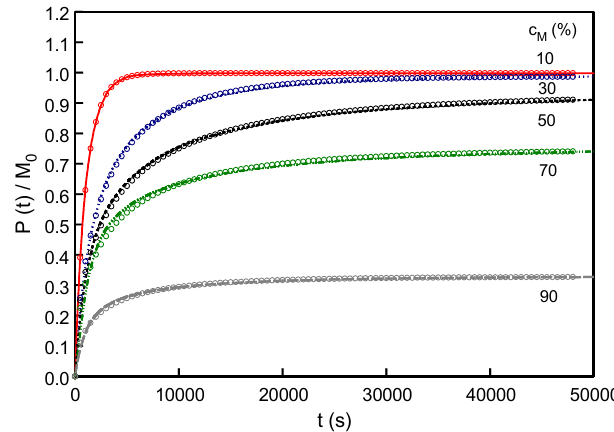
Figure 2. CA simulation data (solid lines) showing the dynamical dependence of photo-product creation for various c M . The symbols show the optimum fit of Equation (1) to the CA curves. In all cases L = 1 µ m, N = 1250, C = 50, c O = 1%, α 0 = α 1 = α 3 = 0, α 2 = 10 5 cm − 1 , β = 10 − 2 s − 1 and NP 0, i = 2